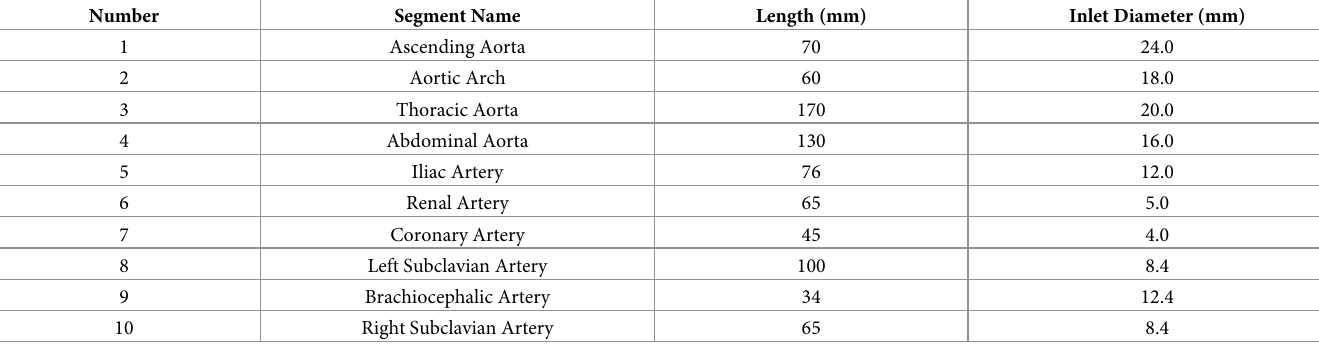
Table 1. Geometric characteristics of the aorta mold.